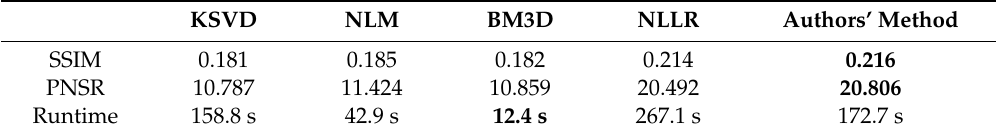
Table 4. Comparison of the di ff erent denoising methods applied in Figure 15i. Bold highlights indicate the best results.